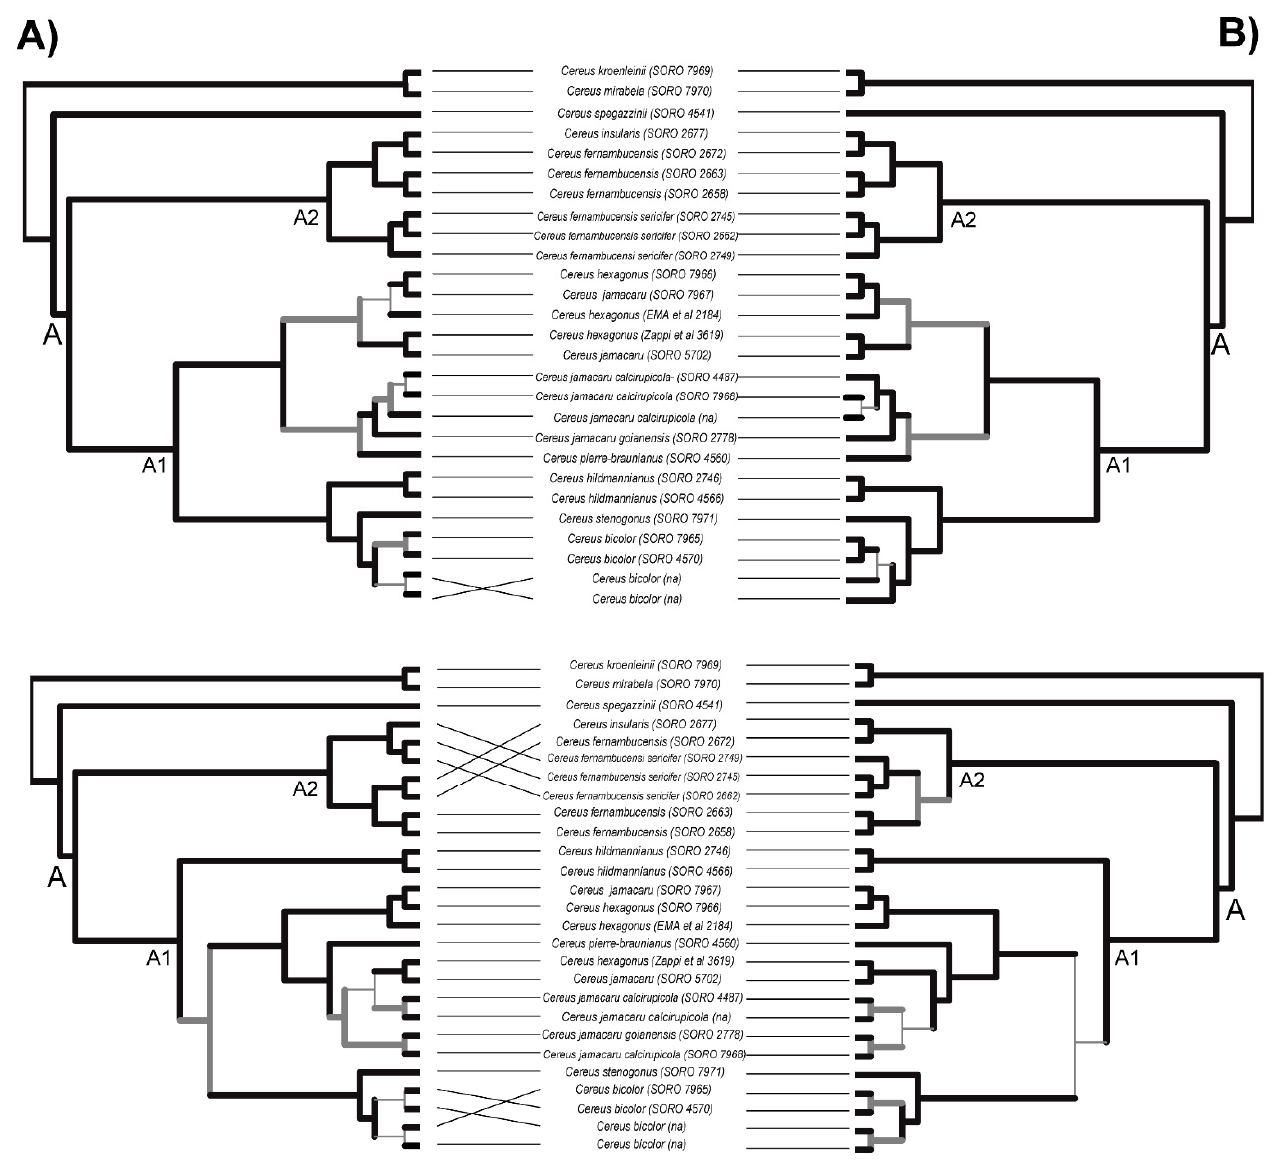
Figure 2. Comparison of phylogenies of Cereus clade A inferred with Cereus-noncoding ( A ) and Cereus-all ( B ) sub-datasets, using coalescent-based (upper) and ML concatenated (down) approaches. The branches with high support (LPP > 0.95 and BS > 95) are highlighted with thick branch lines, the branches with moderate support (LPP 0.95–0.70 and BS 95–70) are colored with thick gray lines, and the branches with low support (LPP < 0.70 and BS < 70) are shown as thin light lines. LPP, local posterior probability; BS, ultrafast bootstrap. Voucher number of each accession is provided in parenthesis after species names.